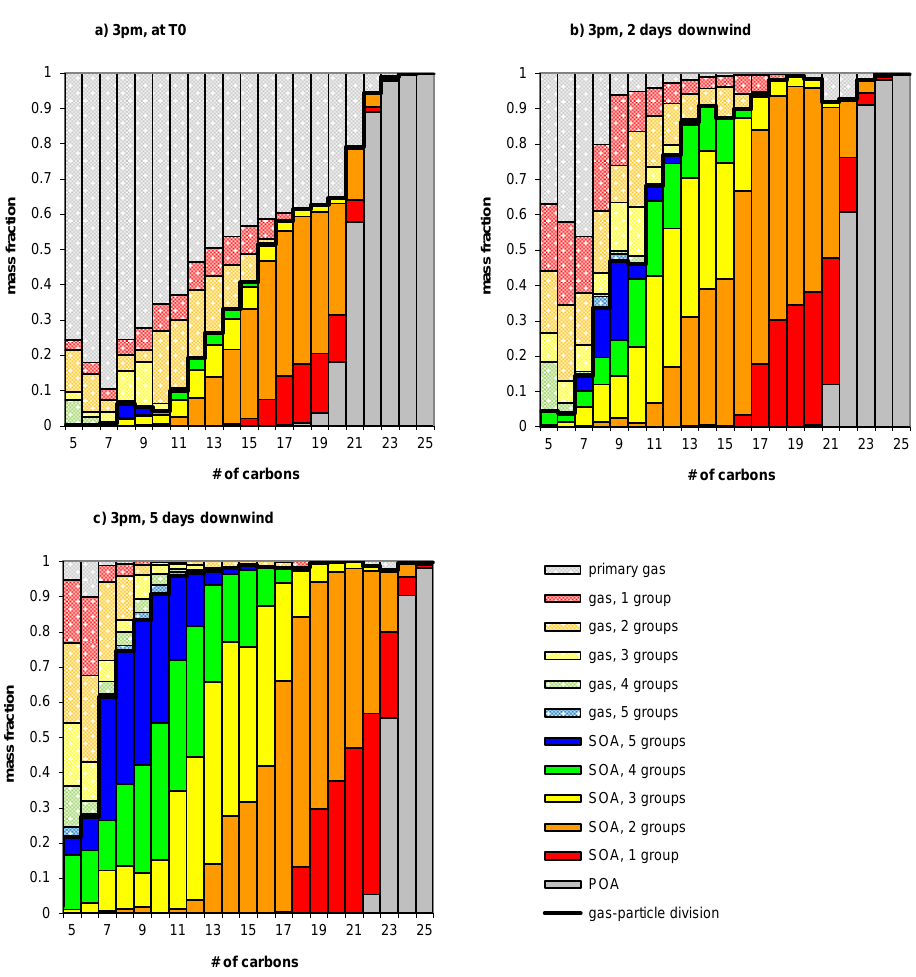
Fig. 8. Gas-particle partitioning by carbon number and number of functional groups. Panels represent the situation at 15:00, (a) at T0, and (b) 2 days and (c) 5 days downwind. Solid colors (lower portion of plots) are particle phase; semi-transparent colors (upper portion of plots) are gas phase. Colors represent number of functional groups per